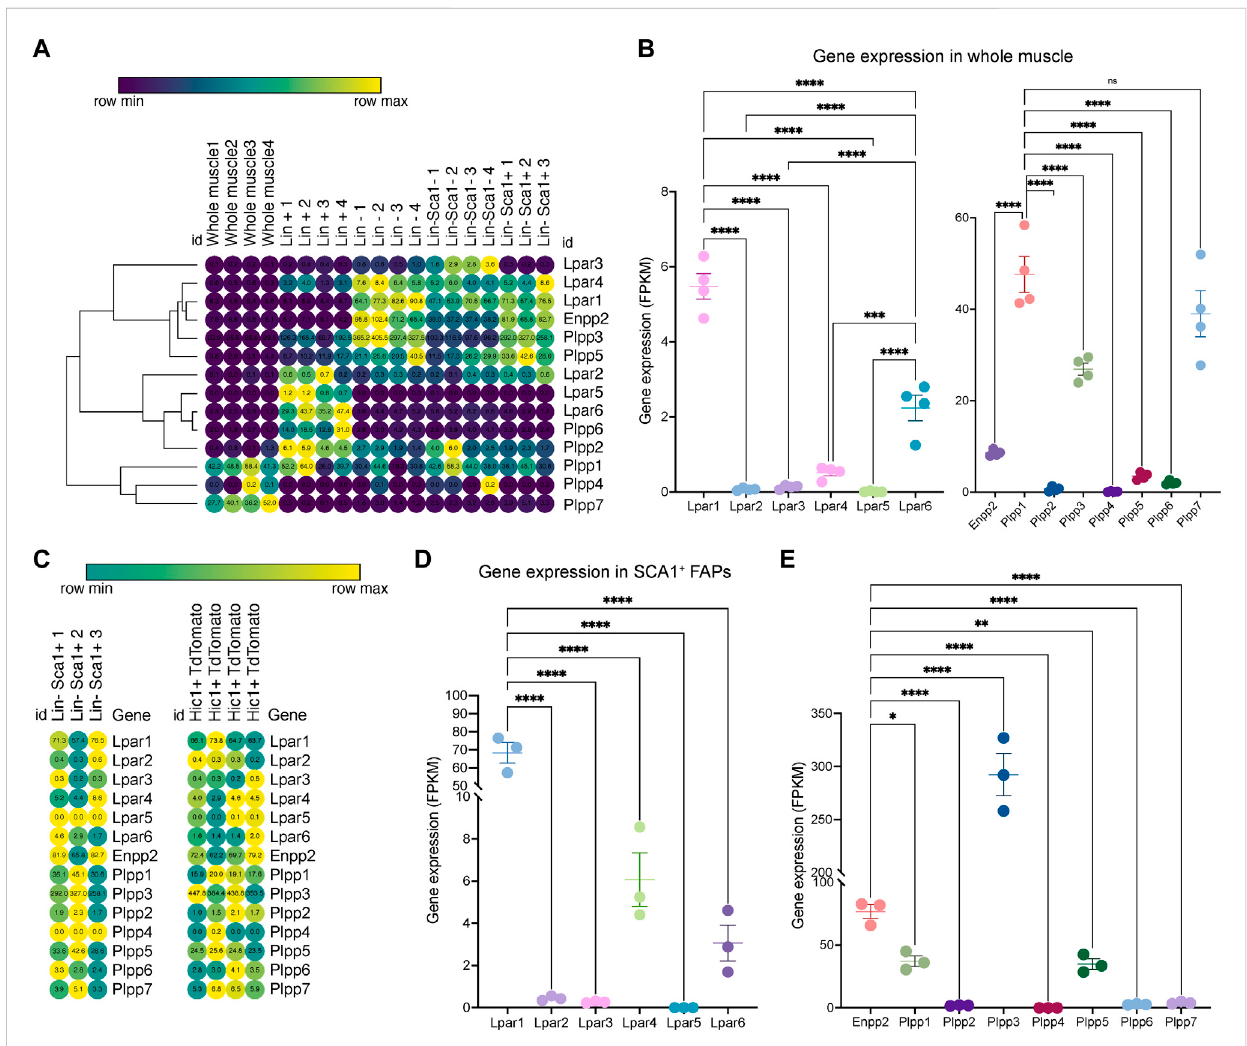
FIGURE 1 Bulk RNAseq transcriptomics analysis revealed differential gene expression of the ENPP2-LPAR-PLPP network. (A) Heat map showing gene expression levels of Lpar , Enpp2 , and Plpp genes in whole skeletal muscle tissue, Lineage + , Lineage − , and Sca1 + FAPs from a bulk RNAseq library (Scott et al., 2019). Gene expression is shown as fragments per kilobase of exon per million mapped fragments (FPKM). (B) Quanti fi cation of Lpar , Enpp2 , and Plpp genes transcript abundance (FPKM) in muscle tissue. (C) Heat map showing gene expression levels of Lpar , Enpp2 , and Plpp genes in Lineage − Sca1 + FAPs and Hic1+ tdTomato expressing cells (Scott et al., 2019). (D) Quanti fi cation of Lpar (1 – 6) genes transcript abundance (FPKM) in Sca1 + FAPs. (E) Quanti fi cation of Enpp2 and Plpp genes transcript abundance (FPKM) in Sca1 +